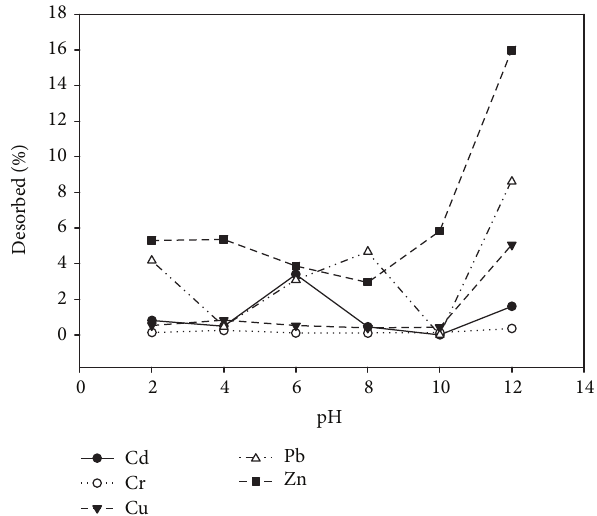
Figure 4: Percentage of heavy metals desorbed plus any precipitated species at different pH for multicomponent desorption scenario [24].